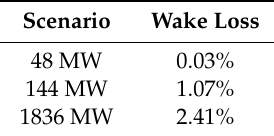
Table 4. Scenario wake losses. Larger wind farms have more internal wake losses because there are more turbines causing obstructions within the